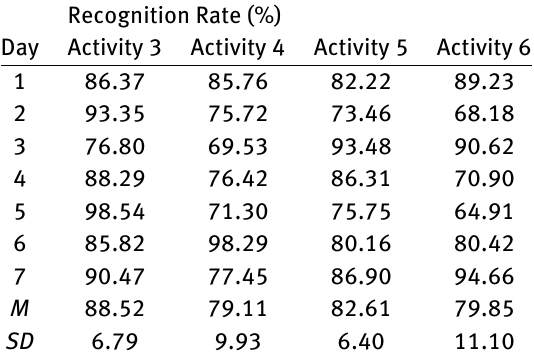
Table 2: Self validation for all days (MavHome dataset).